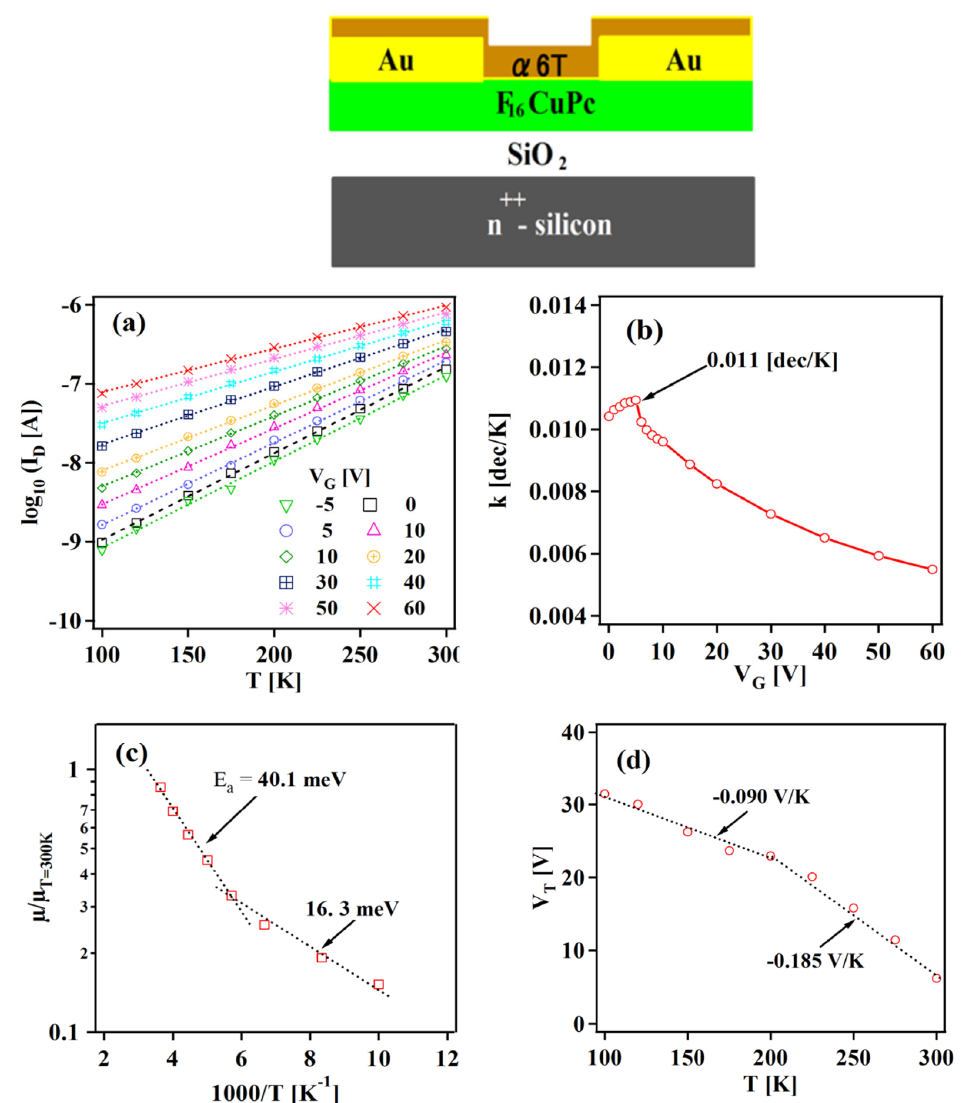
Figure 5. ( a ) Dependence of log ( I DS ) on the temperatures at different V GS , ( b ) dependence of k on V GS in log ( I DS ) = kT + c 0 obtained from data in ( a ), ( c ) temperature dependence of µ , and ( d ) temperature dependence of V T of the α 6T (20 nm)/F 16 CuPc (50 nm) OFET device in the linear regime. Reproduced with permission from [60] Scientific Research, 2016. Note: I D and V G in ( a ) are I DS and V GS ,